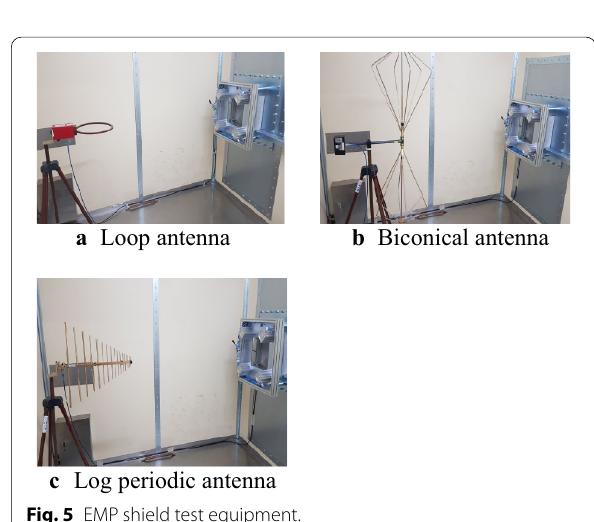
Fig. 5 EMP shield test equipment.